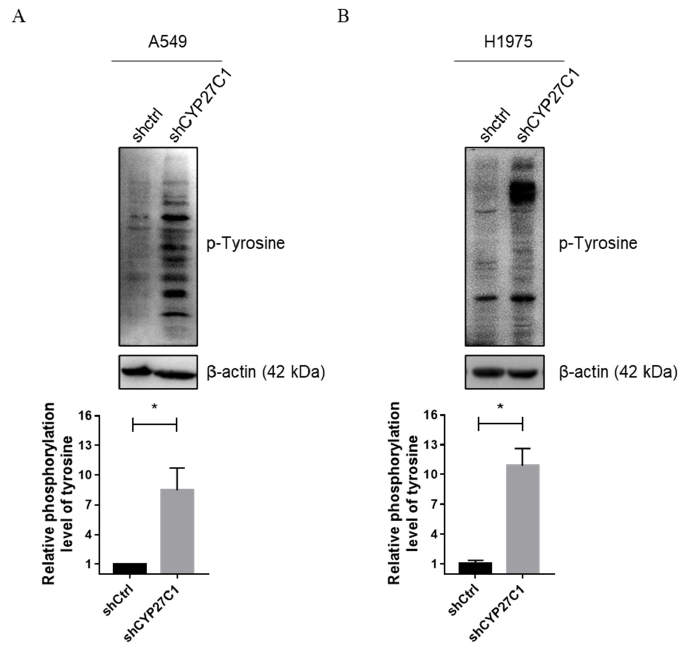
Figure 3. Stable CYP27C1-knockdown increases basal tyrosine phosphorylation level. Protein level of stable CYP27C1-knockdown A549 ( A ) stable CYP27C1-knockdown H1975 cells ( B ) and the corresponding control cells was detected by immunoblot analysis. Grey scales of the bands were measured by Gel-Pro ANALYZER. Results were analyzed by unpaired two-tailed T test. Lines with blunt arrow indicated the comparison between different groups. *, p <